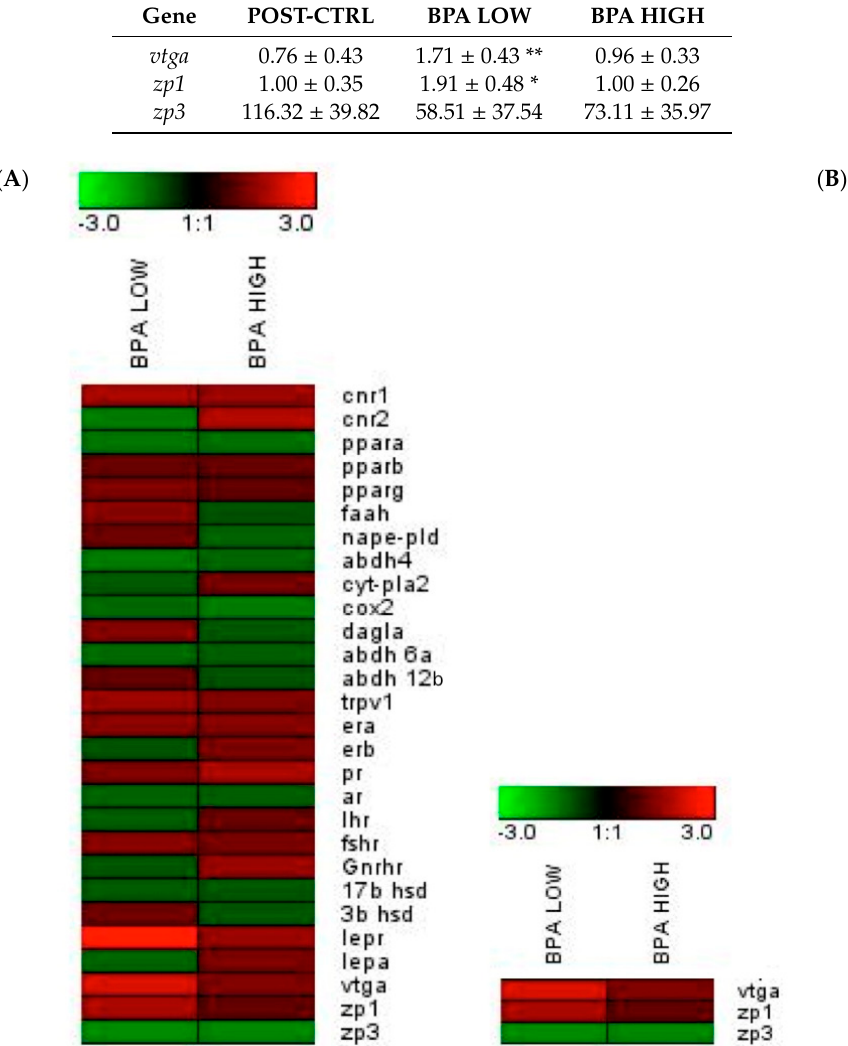
Figure 6. Gene expression heat maps in the testes ( A ) and the liver ( B ). Scales of colors represent fold-change values in relation to the POST-CTRL group (green, down-regulation; red, up-regulation).